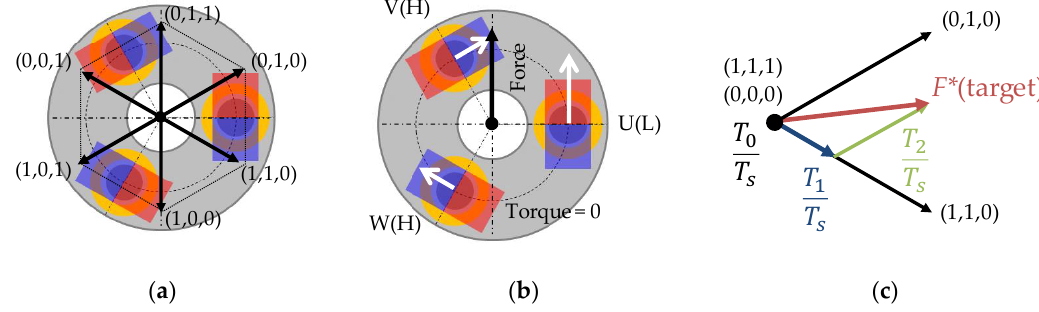
Figure 7. Switch states and force direction: ( a ) force direction in each switch state, ( b ) force direction on (0,1,1), and ( c ) composite of force vector between (1,1,0) and (0,1,0).